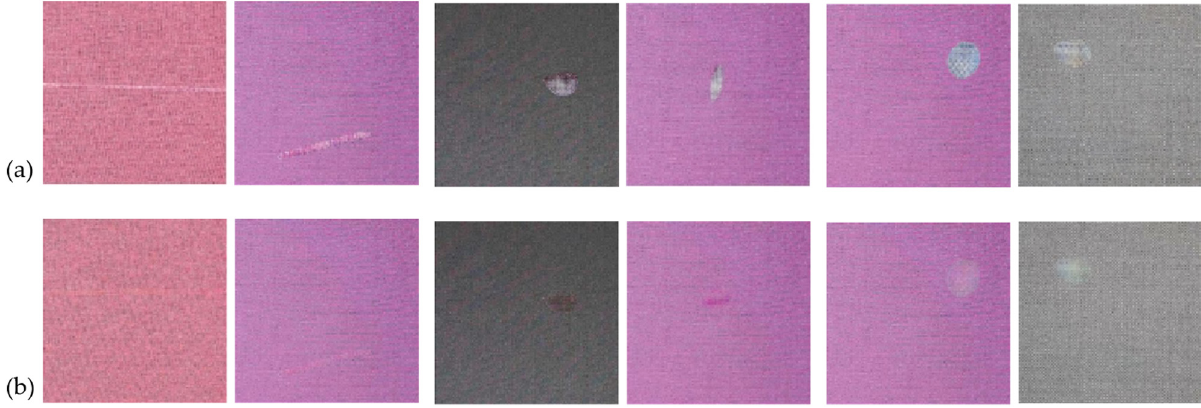
Figure 4: Samples of generated fabric defect images by using DPGAN. ( a ) The generated fabric defect images after Stage 1; and ( b ) the generated fabric defect images after Stage